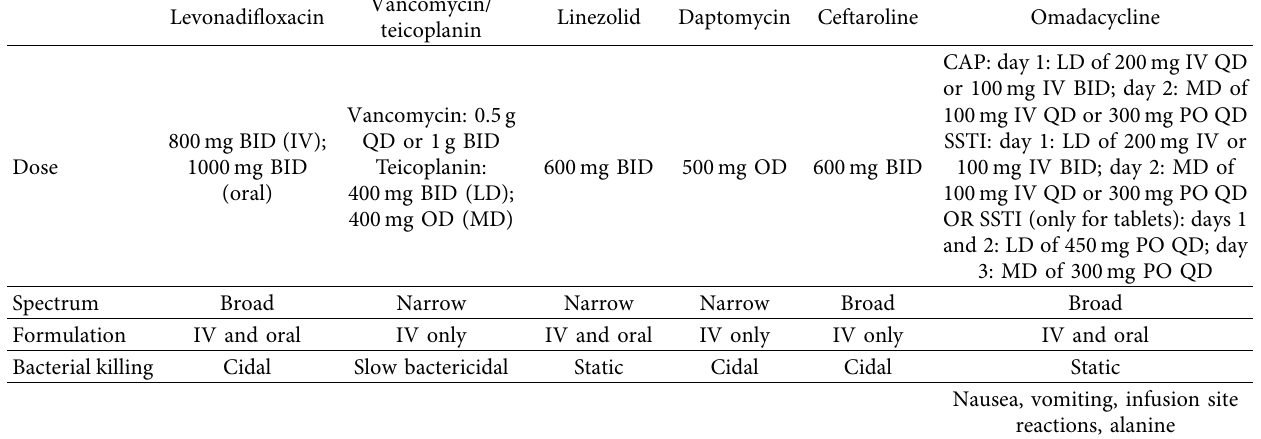
Table 5: Comparative efficacy and safety parameters between anti-MRSA agents (Reddy et al. [76]. Vancomycin/ Levonadifloxacin teicoplanin